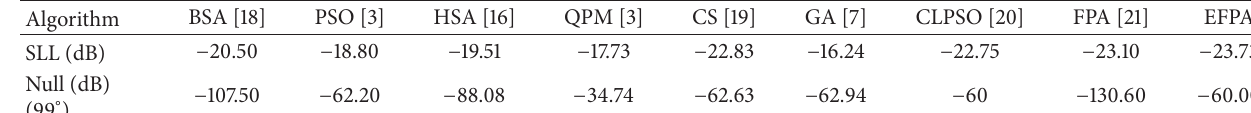
Table 13: Performance of different algorithms for 32-element LAA.